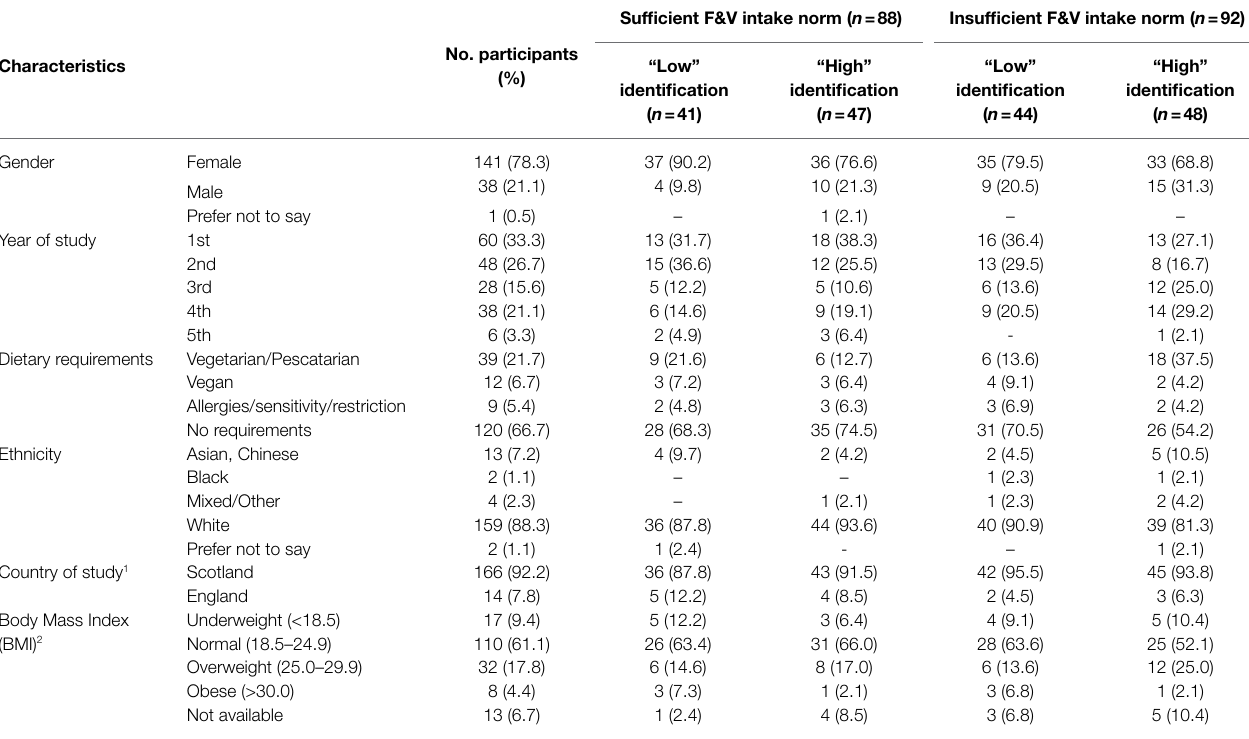
TABLE 4 | Participant demographics and breakdown of percentages ( N = 180).